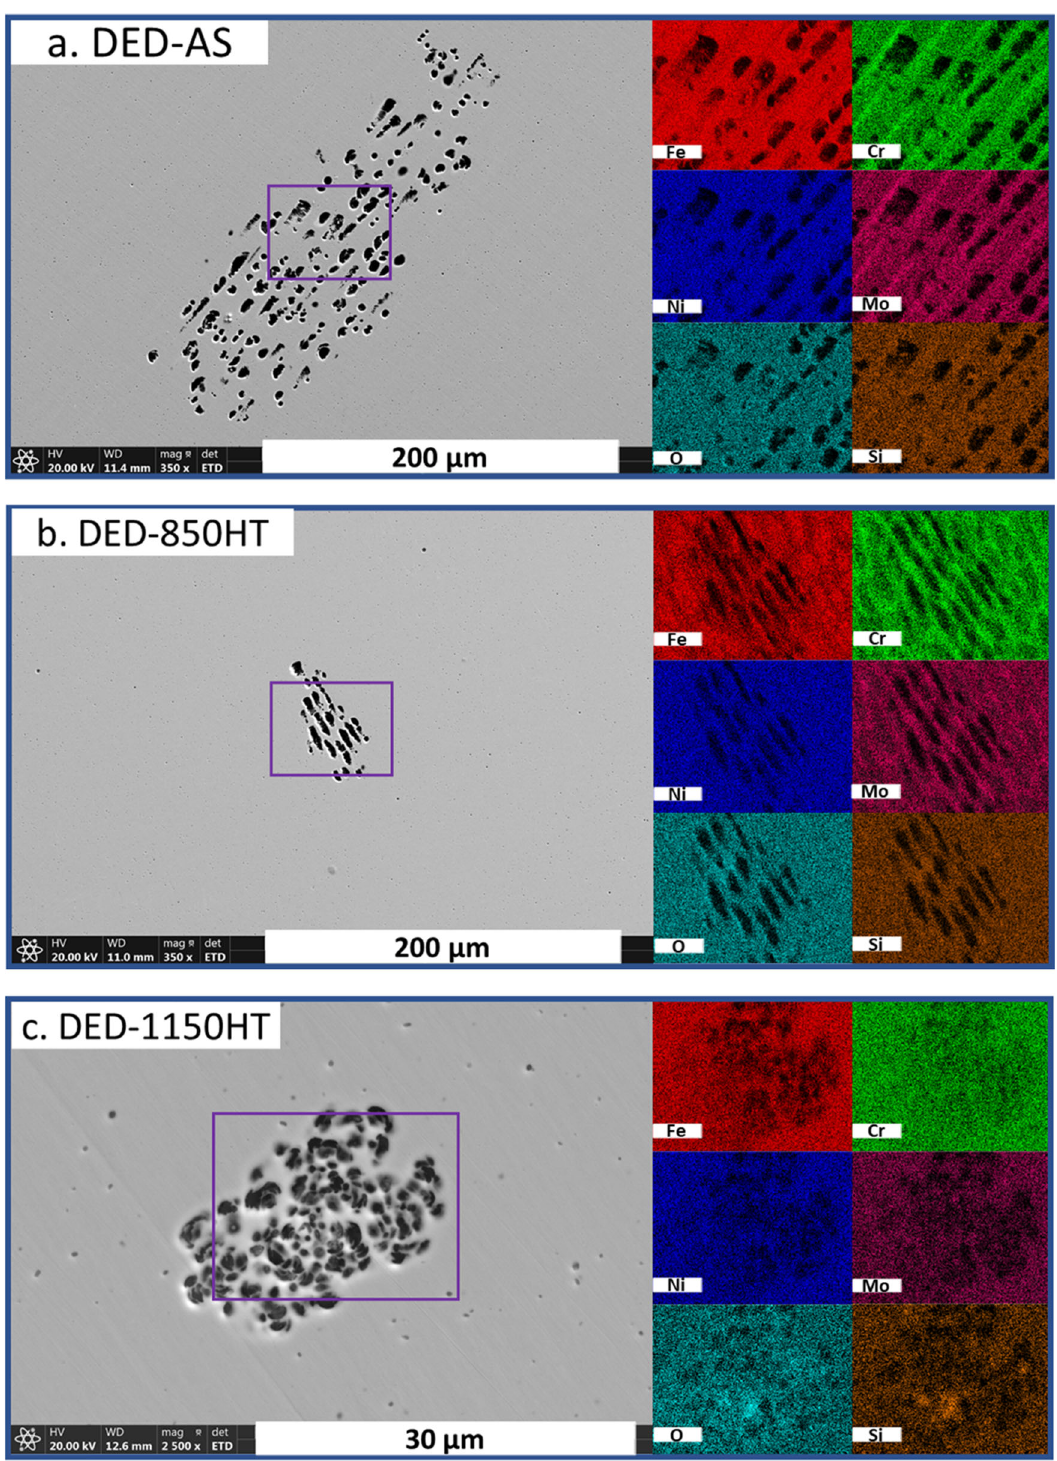
Fig. 6 SEM morphologies of pits. SEM images show the pit morphologies and corresponding EDS mappings results of the as-manufacture and heat-treated DED 316L SS: a DED-AS, b DED-850HT, and c DED-1150HT.